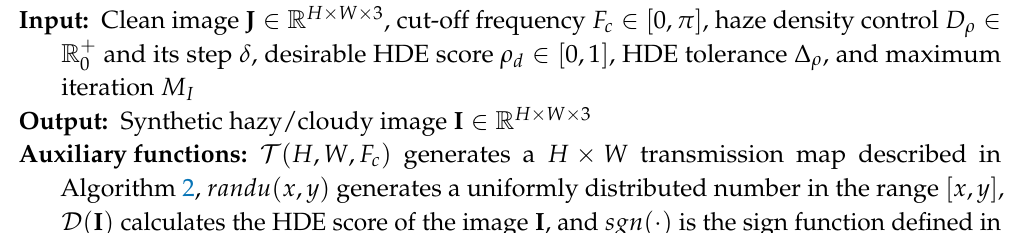
Algorithm 3 Synthetic hazy/cloudy image generation